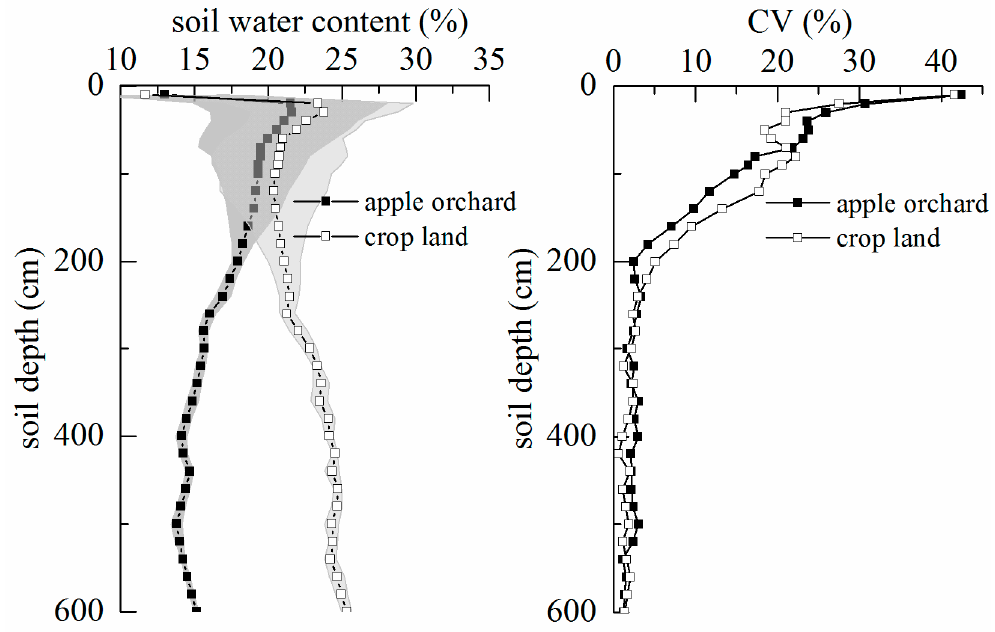
Figure 3. The vertical distribution of soil moisture for different land use types. Cropland data reflect mean indexes on all cropland sites. The shading is standard deviation (STDEV). The equation to calculate it is: STDEV = , and the same below.